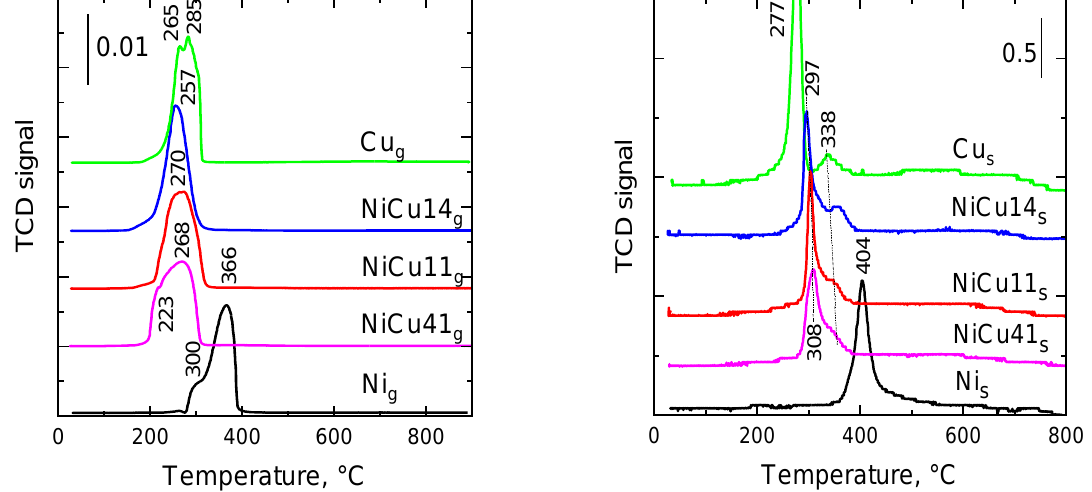
Figure 3. TPR profiles of granular ( left ) and sputtered Ni-Cu oxide catalysts ( right ). In both cases, the TCD intensities are per gram of oxides.